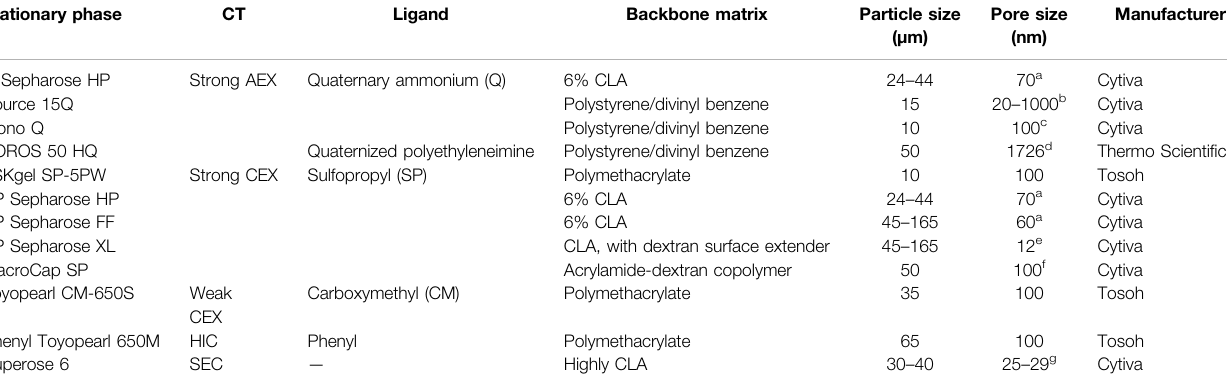
TABLE 2 | Structural properties of resins used to purify commercial PEGylated proteins. Information is based on manufacturer ’ s data sheets unless cited otherwise. Stationary